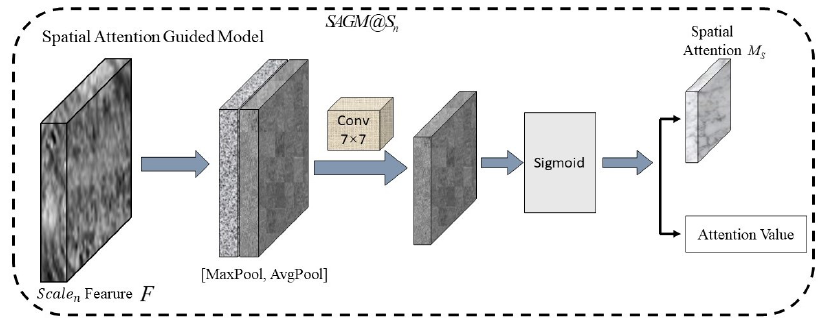
Figure 4. The structure of a SAGM.